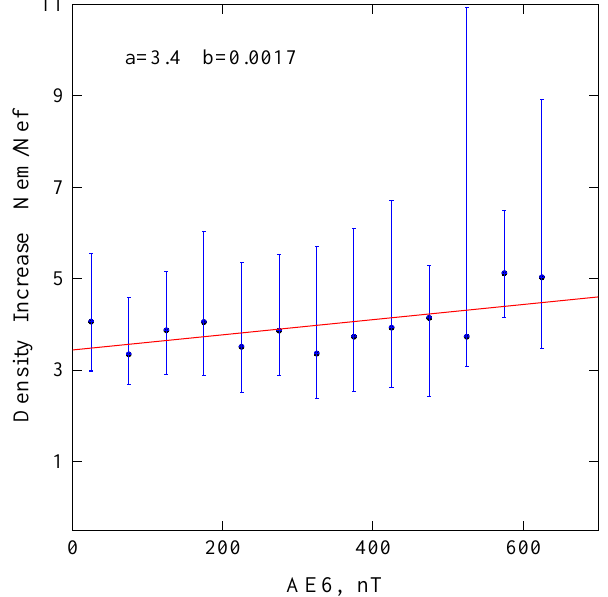
Fig. 7. Relative density increase in the polar cliff as function of al- titude. The format of data presentation corresponds to that in Fig. 6, except that this time a linear regression line has been fitted to the data; the associated coefficients are given in the upper right-hand corner. Note that the results presented in this figure refer to a geo- graphic longitude of 0 ◦ .